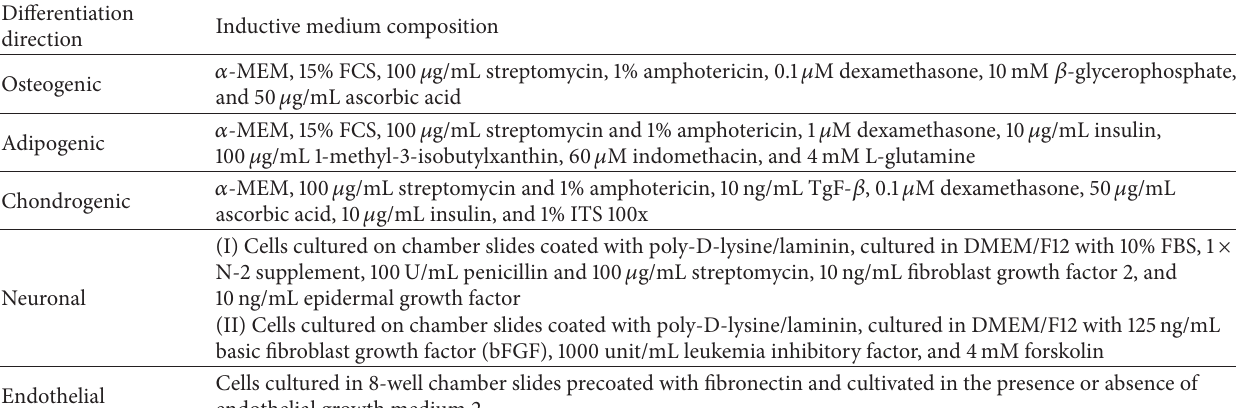
Table 2: Multilineage induction